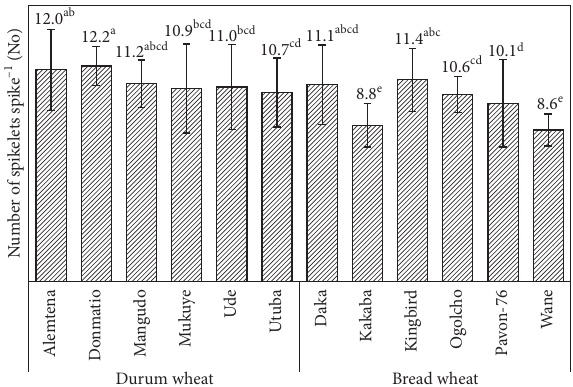
Figure 3: Means for the main effects of variety and water stress on the number of spikelet per spike of durum and bread wheat in